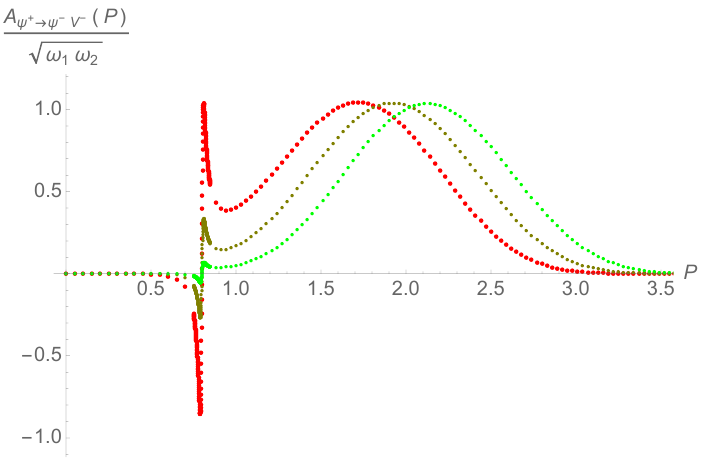
Figure 18 . A sample plot of the P -integrand in (3.6) for FZZT parameter s = 0 : 4 ; 0 : 5 ; 0 : 6 (from red to green), after taking into account the normalization of the long string asymptotic state as in 3.1. The outgoing long string renormalized energy is taken to be (cid:15) 2 = 0 : 3, and the closed string energy is ! 3 = 0 : 8 + 0 : 01 i . We have performed the x -integral with the counter terms included p for P < Re( ! 2 ). For su(cid:14)ciently large s , the P -integral is dominated by the contribution near 3 P (cid:24) ! 1 , whereas the contribution from the P -integral up to P (cid:24) needed) becomes